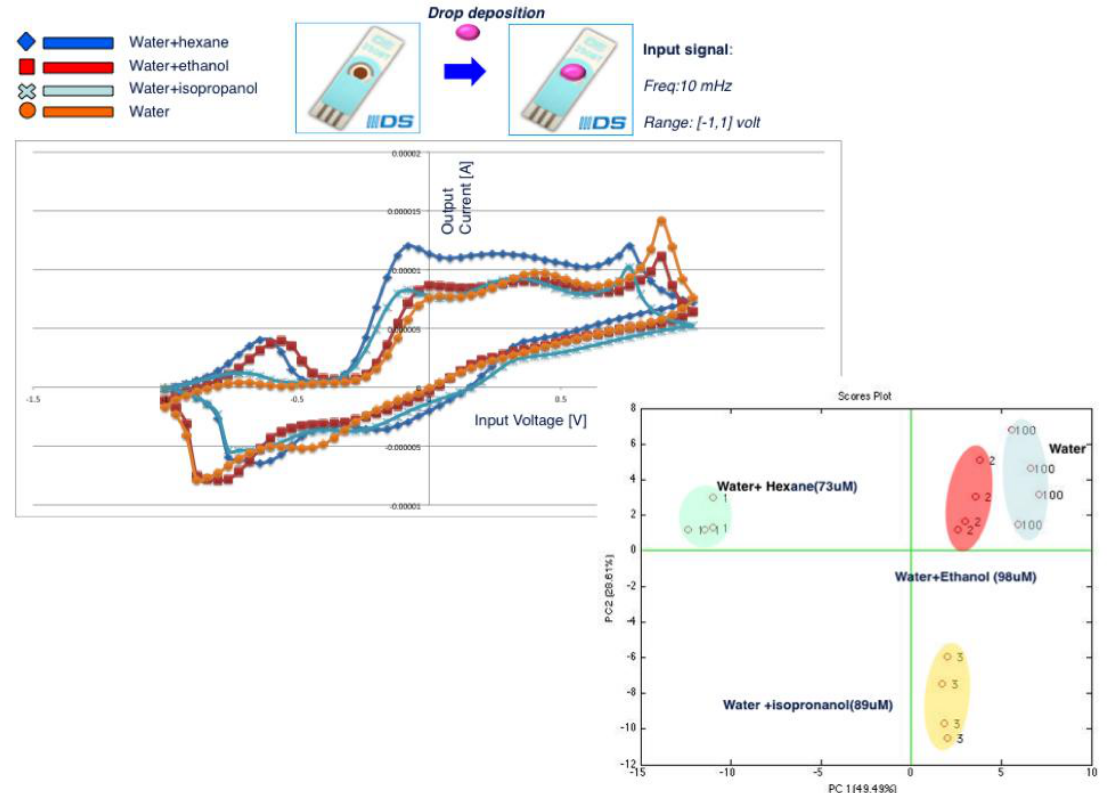
Figure 3. The voltage modulation applied to the liquid sensor provides in each time a value of current. The peaks of current are referred to different redox processes. All the current responses represent an electrochemical pattern of the sample (each marker corresponds to a different specimen). The scores plot obtained from a PCA model built on the collected data shows different clusters for different